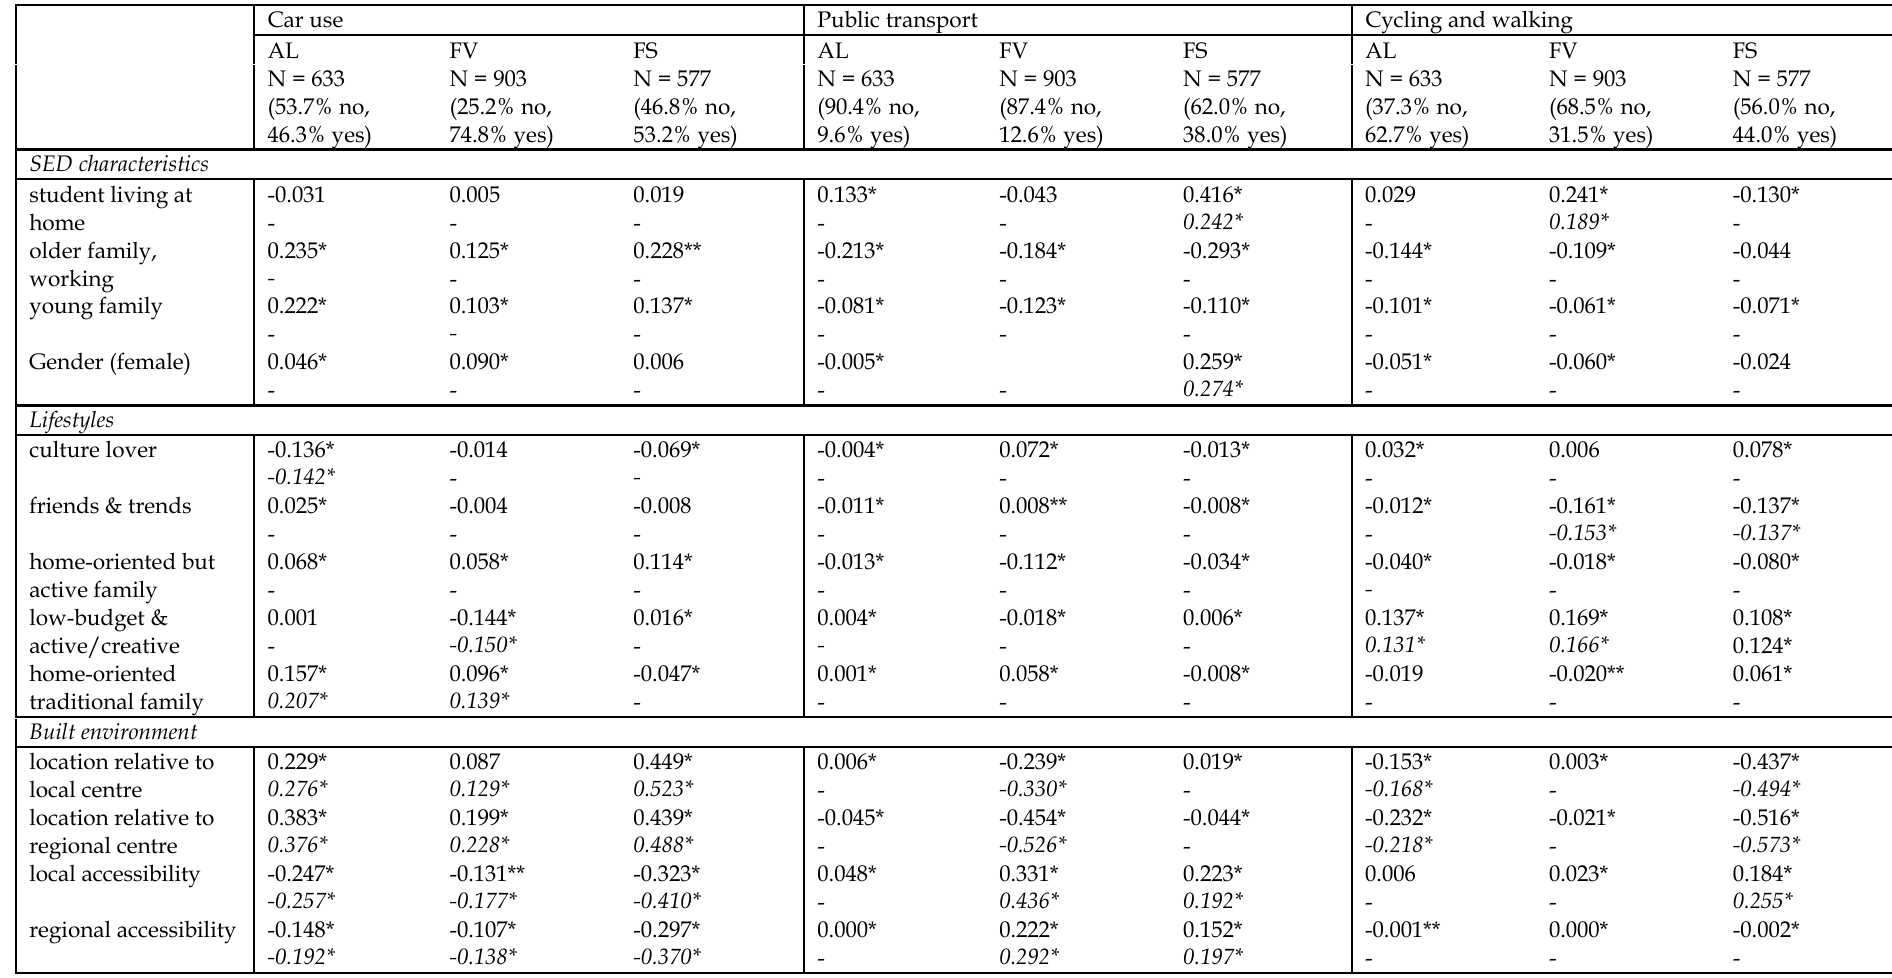
Table 3. Standardized direct and total effects on modal choice for different leisure